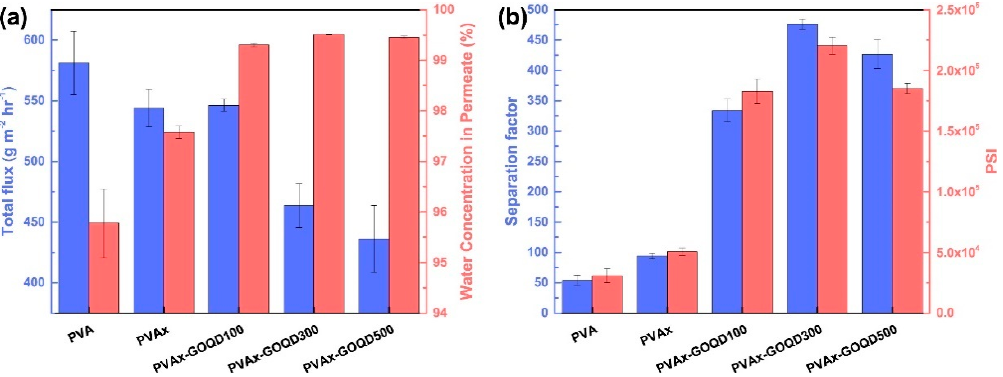
Figure 2. Dehydration performance of pervaporation membranes in the separation of 70/30 wt% i-PrOH/water mixture at 25 °C: ( a ) Water concentration and cumulative flux in permeate and ( b ) pervaporation separation index (PSI) and separation factor.